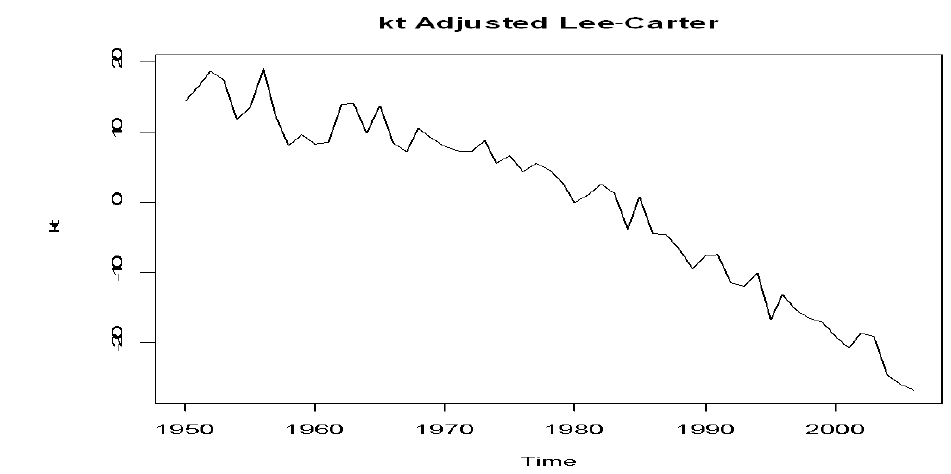
Fig. 6. Poisson Lee-Carter adjusted k t – ASLC, Italian total population